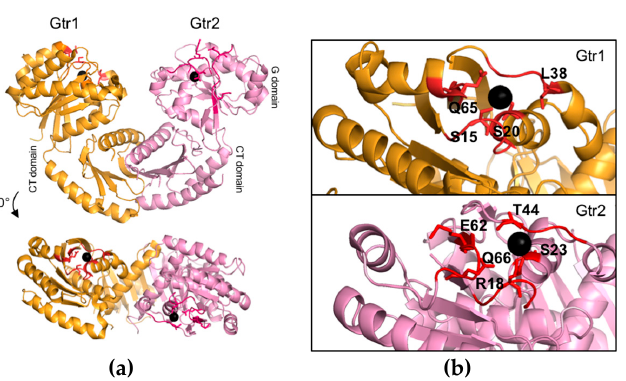
Figure 2. ( a ) Cartoon representation of the structure of the heterodimeric Gtr1–Gtr2